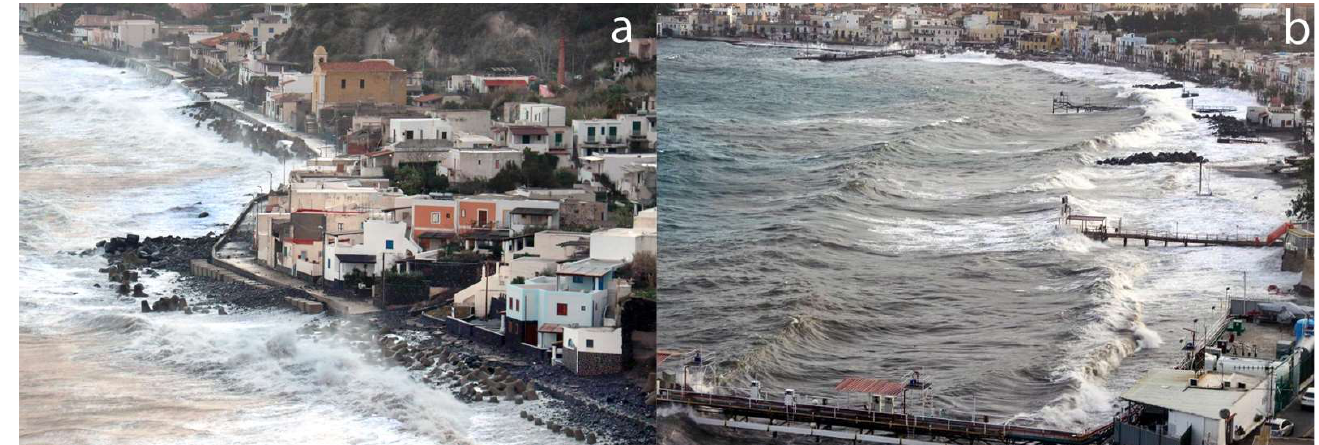
Figure A12. The Acquacalda village ( a ) and the Marina Lunga waterfront ( b ) are increasingly exposed to storm events and marine ingression.